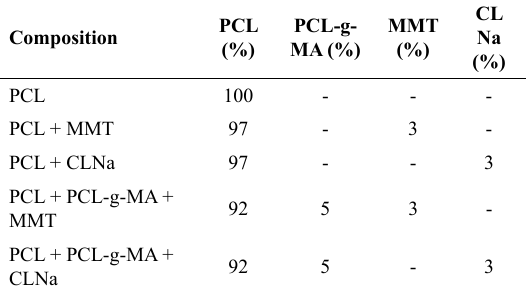
Table 1. Composition of PCL